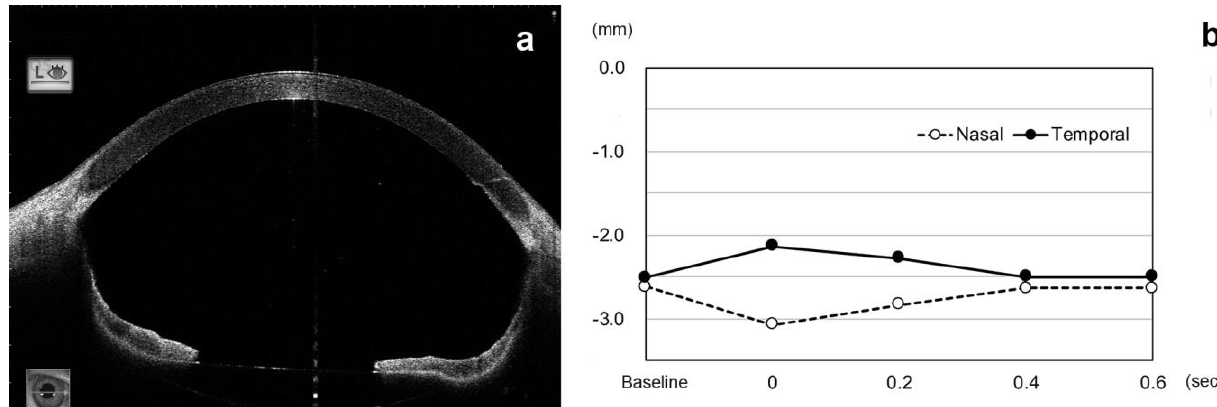
Figure 6. AS-OCT images of a 55-year-old man with an impending pupillary block after intrascleral fixation of an IOL without a peripheral iridectomy. ( a ). AS-OCT image indicates that there is an excessive iris retraction and the anterior chamber depth is 7.07 mm. ( b ). Analysis of the AS-OCT images indicates that the nasal and temporal heights of the iris changes induced by the eye movements, but the height is maintained very low.